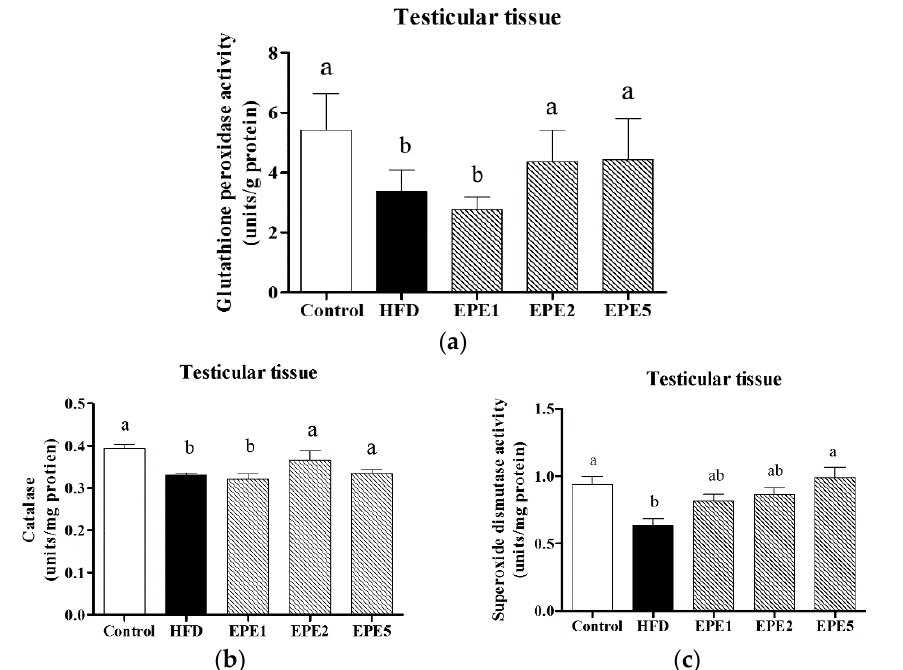
Figure 4. Effects of Echinacea purpurea ethanol extract on ( a ) glutathione peroxidase activity, ( b ) catalase, and ( c ) superoxide dismutase activity in testicular tissue of HFD-induced obese rats after 5 weeks. Data are shown as the mean ± S.E.M. (n = 5). The values with different superscript letters ( a , b ) are significantly different ( p < 0.05), as determined via one-way ANOVA, and were analyzed by Duncan’s multiple range test.